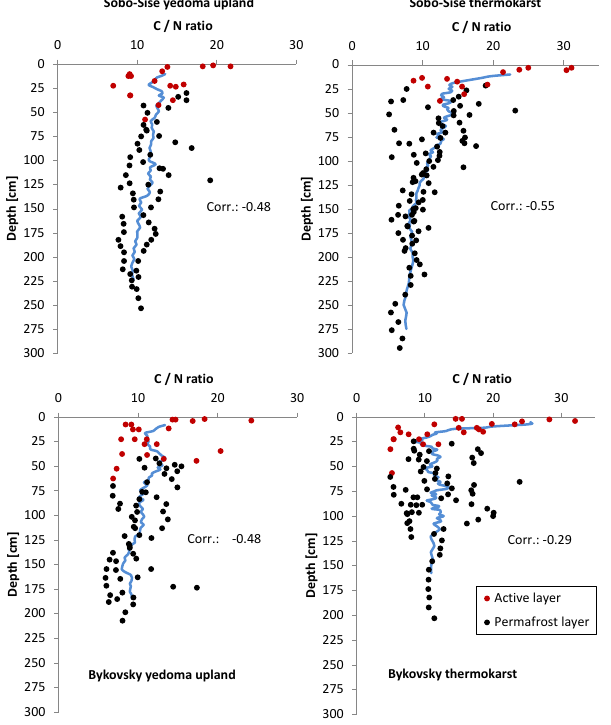
Figure 2. C / N ratio for yedoma upland and thermokarst samples on Sobo-Sise and Bykovsky Peninsula. Blue lines indicate the run- ning mean for the entire sample set (including active layer and per- mafrost layer samples). The correlation (Corr.) (Pearson correla- tion) between C / N ratio and depth indicates a decreasing C / N ratio with increasing depth ( p< 0 . 01).